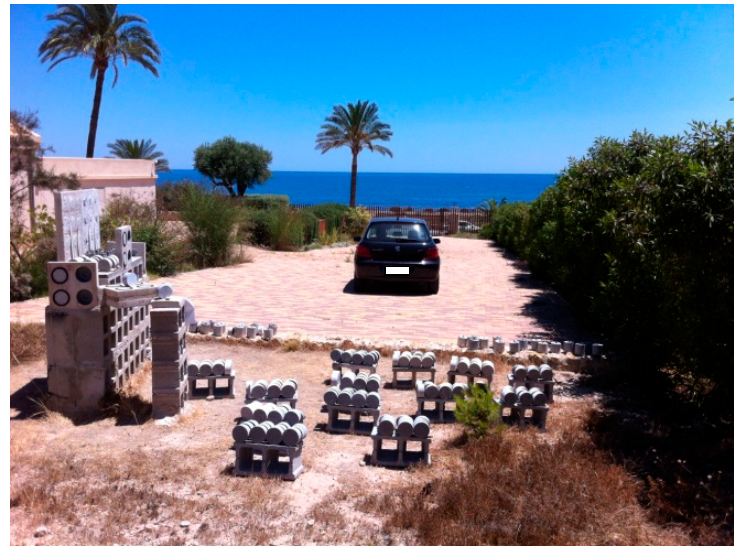
Figure 2. Image of the samples placed in the exposure station of Santa Pola’s Cape (province of Alicante). As can be observed, the distance from the Mediterranean Sea is about 100 m.